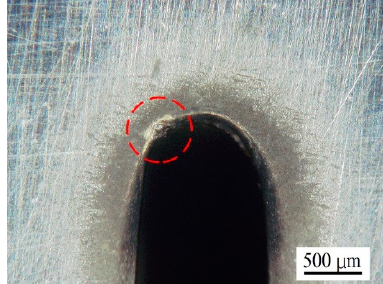
Figure 14. Surface with burns.